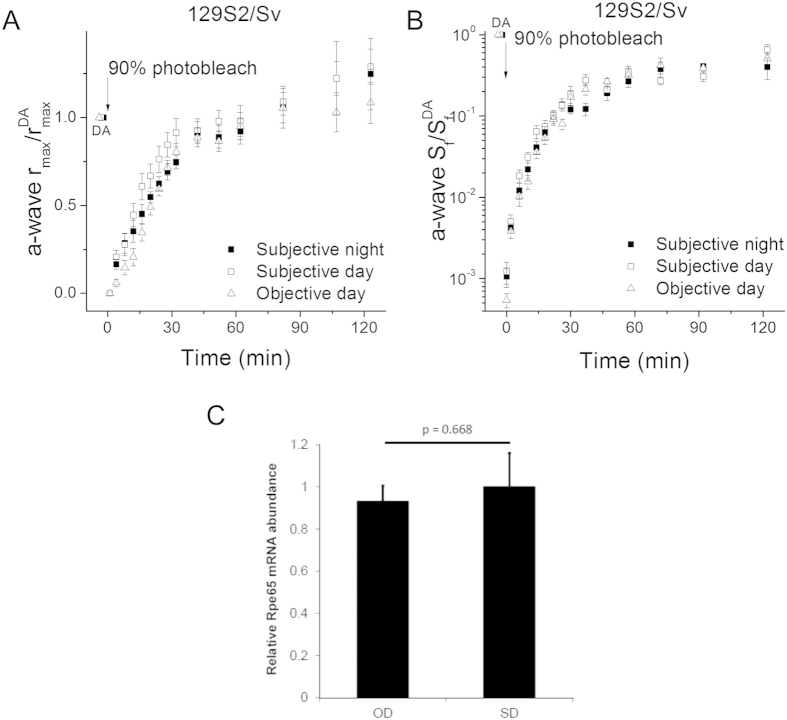
Lack of effects of the circadian clock and light history on rod dark adaptation in melatonin-deficient 129S2/Sv mice.(A) Normalized in vivo ERG scotopic a-wave maximal response recovery in 129S2/Sv mice following 90% pigment bleach at t = 0 at subjective night (solid squares, n = 6), subjective day (open squares, n = 8), and objective day (open triangles, n = 7). (B) Normalized in vivo ERG scotopic a-wave sensitivity recovery in 129S2/Sv mice following 90% pigment bleach at t = 0 at subjective night (solid squares, n = 6), subjective day (open squares, n = 8) and objective day (open triangles, n = 7). (C) Rpe65 mRNA abundance in objective day (OD) vs. subjective day (SD) in 129/Sv mice as quantified by qRT-PCR. Transcript levels of Rpe65 were quantified by qRT-PCR with normalization to Gapdh. Error bars represent standard error of the mean (SEM) across five biological replicates per condition. P-value, two-tailed Student’s t-test.